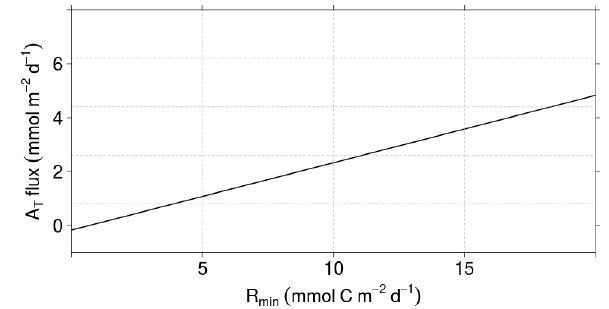
Figure 9. Sensitivity of the benthic A T flux (dashed line) and the net A T generation (solid line) towards a range of mineralization rates in the